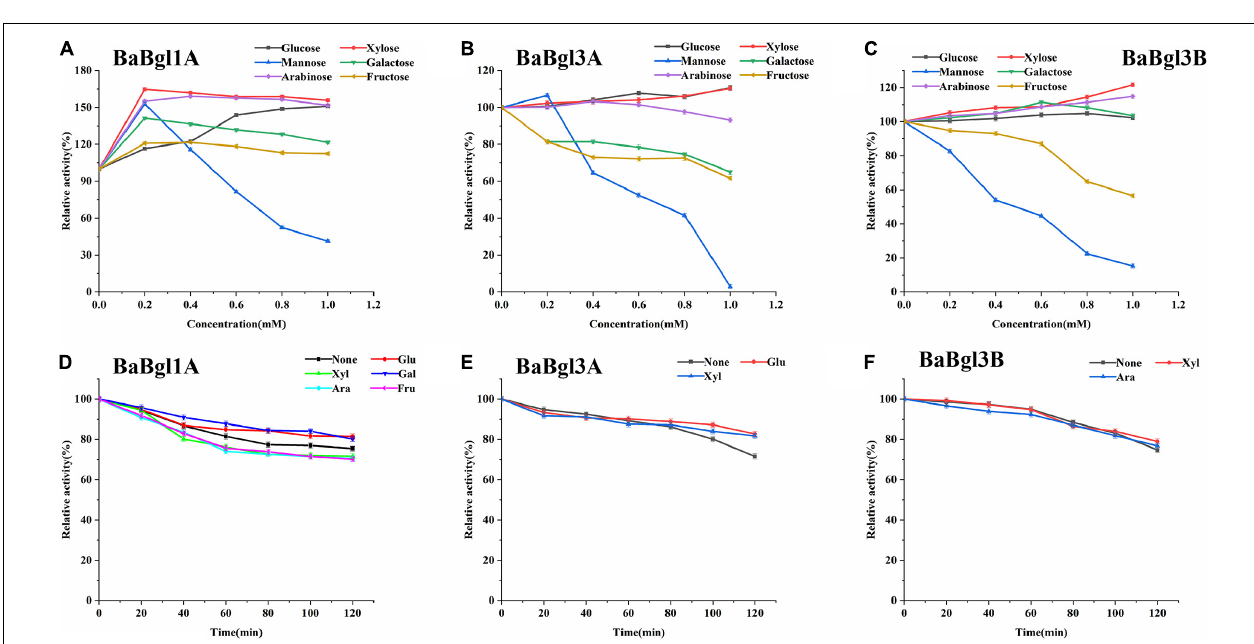
FIGURE 4 | Effects of metal ions and reagents on BaBgl1A, BaBgl3A, and BaBgl3B activity. (A) Effects of metal ions and reagents (5 and 25 mM) on BaBgl1A activity. (B) Effects of metal ions and reagents (5 and 25 mM) on BaBgl3A activity. (C) Effects of metal ions and reagents (5 and 25 mM) on BaBgl3B activity. Values are mean ± SD from three biological replicates.